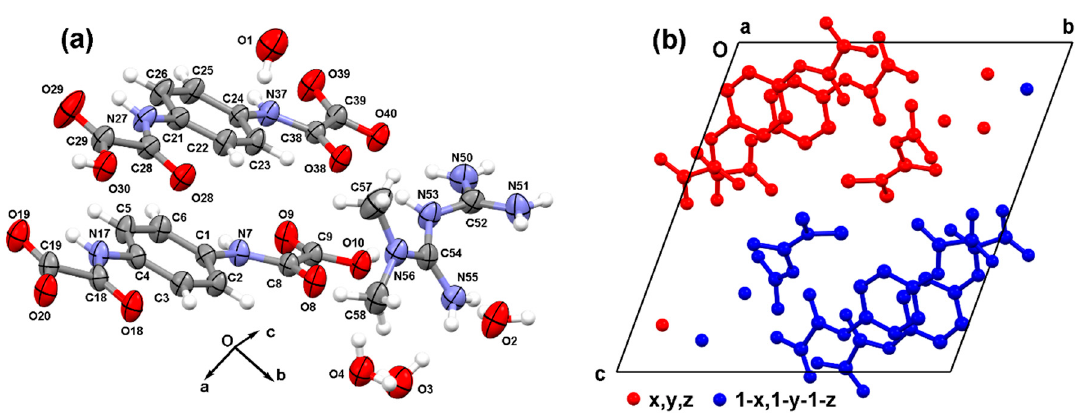
Figure 2. ( a ) Molecular structure of the organic salt H 2 Mf(HpOXA) 2 · 4W showing the atom labelling scheme, displacement ellipsoids are drawn at the 50% probability level. ( b ) Unit cell picture in the bc plane showing two units of H 2 Mf(HpOXA) 2 · 4W ( Z = 2) and symmetry codes, hydrogen atoms are omitted.